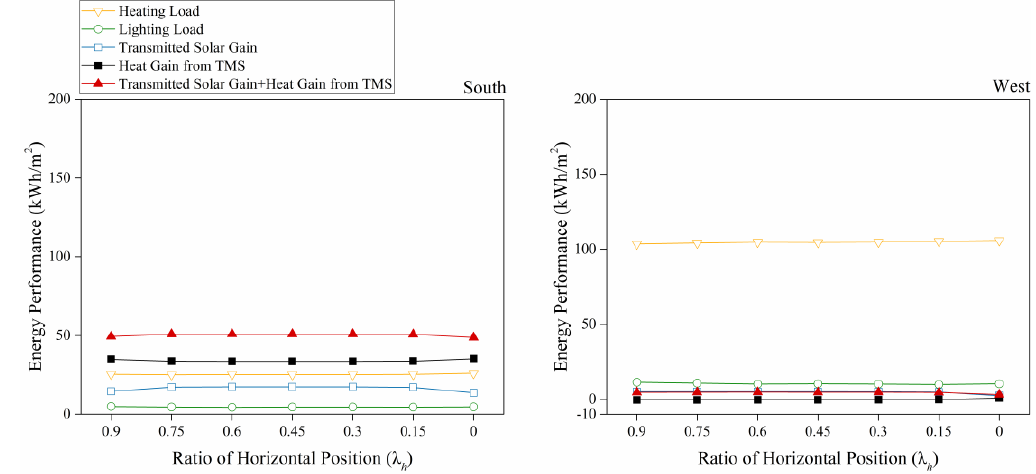
Figure 12. Winter energy performance of different perforated percentages in Group 3.